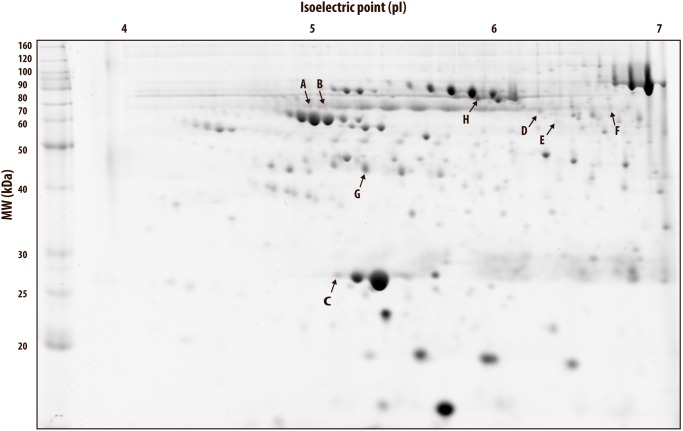
Representative 2DE gel with significant spots.Representative 2-dimensional electrophoresis (2DE) gel of human serum. Protein spots that changed significantly (p<0.05) are marked.